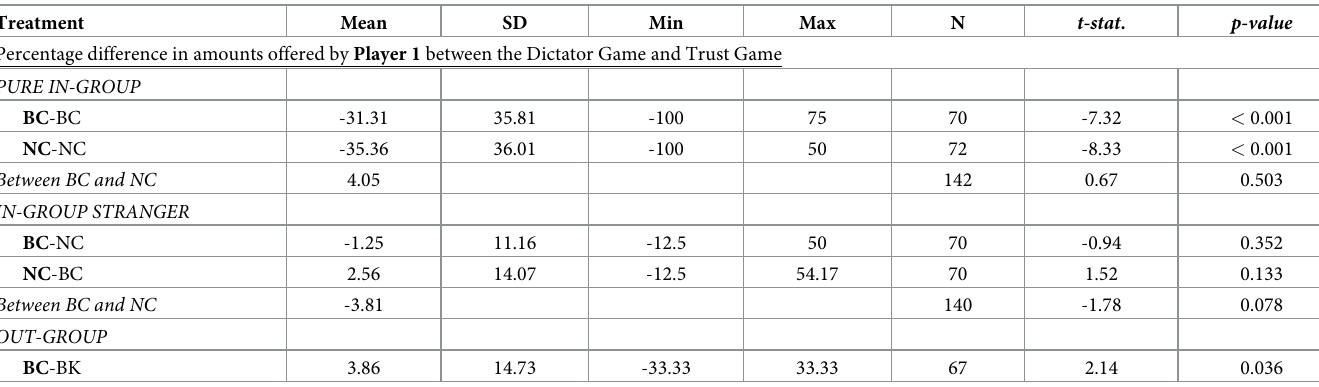
Table 4. Difference in money offered by Player 1 between the Dictator Game and Trust